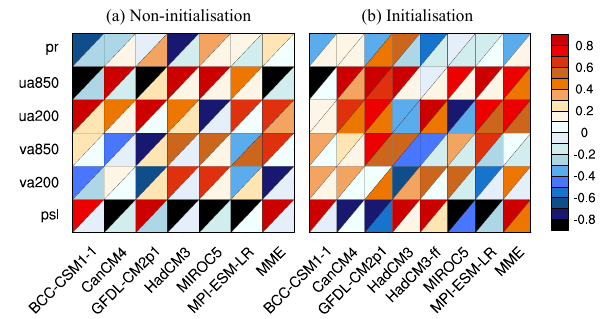
Figure 5. Portrait diagram display of correlation metrics between the observation and the model simulation of the first leading EOF mode for the six fields in the non-initialisation (a) and the initiali- sation (b) . Each grid square is split by a diagonal in order to show the correlation with respect to both the eigenvector (upper left tri- angle) and its associated principal component (lower right triangle) reference